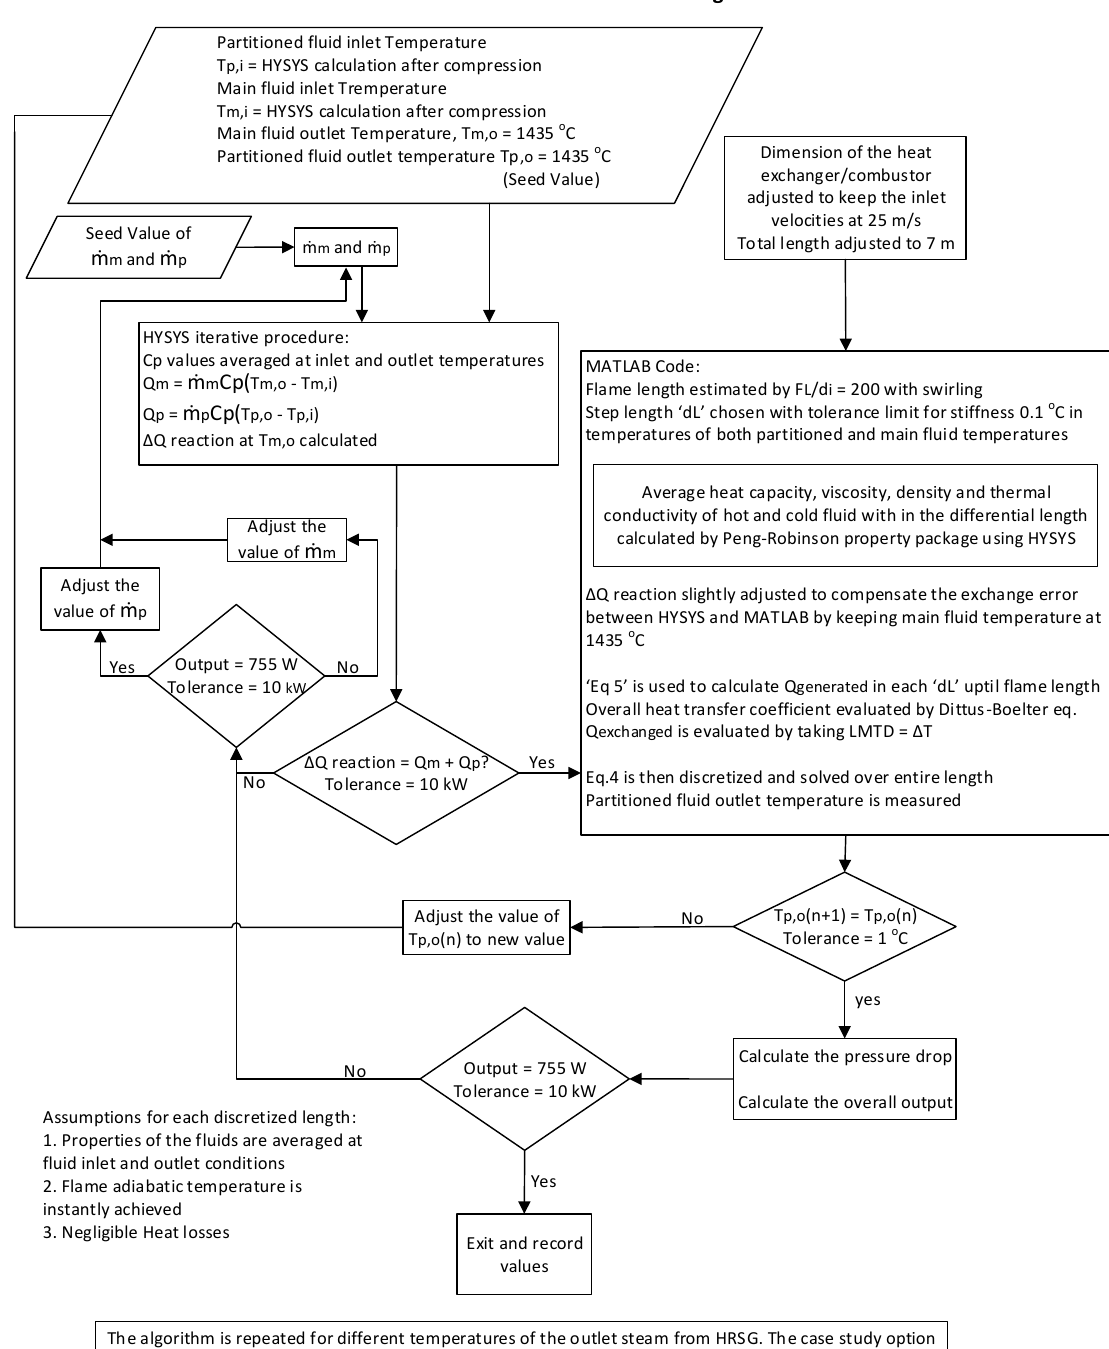
Figure 5. Combustor chamber design and HRSG convergence algorithm. Discretized length = 0.001 m. T p,i , T p,o , m p = inlet temperature, outlet temperature, and mass flow rate of partitioned fluid, respectively. T m,i , T m,o , m m = inlet temperature, outlet temperature, and mass flow rate of main fluid, respectively. Q m and Q p are the heat absorbed or liberated by the main and partitioned fluid, respectively. F L = flame length. d j = jet injection diameter. dL = step length. Seed values for the algorithm were obtained by equating the mass flow rates in heat capacity equation using 1435 °C as the partitioned fluid outlet temperature.